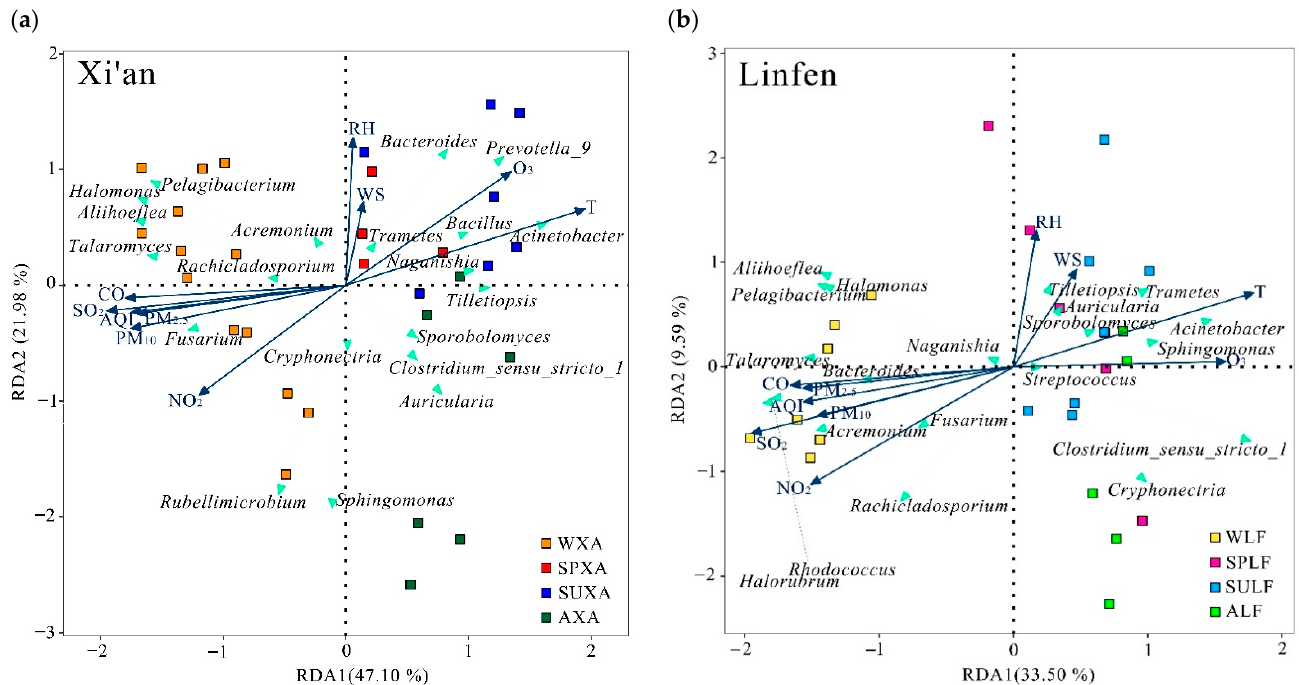
Figure 3. Redundancy analyses of the relationships between environmental factors and dominant microbial community structures in Xi’an ( a ) and Linfen ( b ). Arrows represent pollutant and meteorological factors, triangles represent dominant microorganisms, and squares represent samples in different